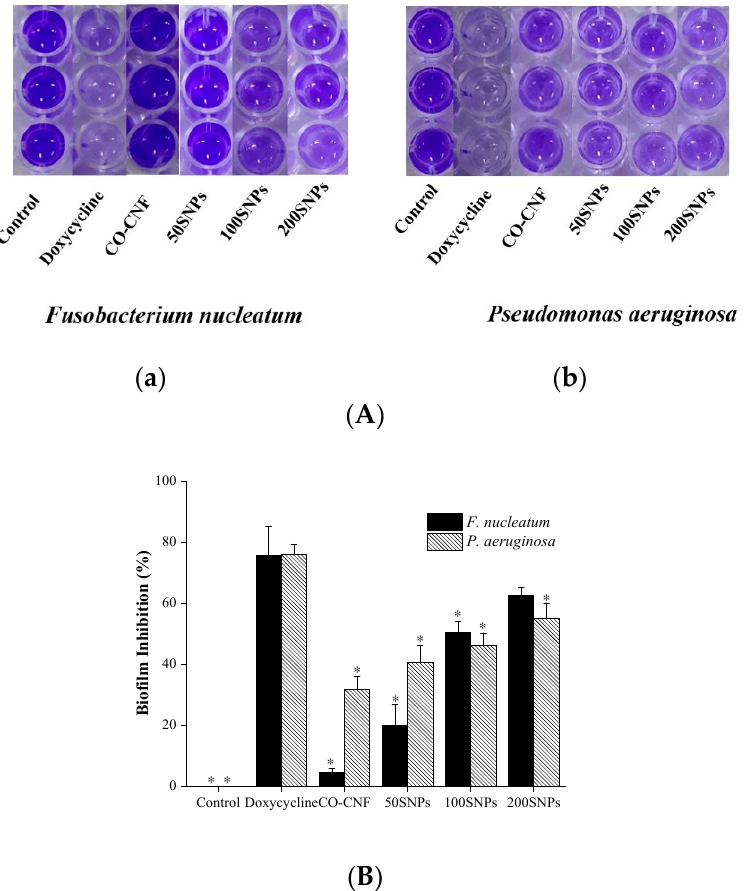
Figure 3. ( A )Visualization of biofilm formation by ( a ) Fusobacterium nucleatum and ( b ) Pseudomonas aeruginosa and ( B ) quantification of biofilm inhibition in Fusobacterium nucleatum and Pseudomonas aeruginosa . Data are expressed as mean ± S.D. ( n = 3). The asterisk (*) represent a significant difference ( p < 0.05) from positive control (doxycycline) analyzed by Tukey’s test. CO-CNF: κ -carrageenan oligosaccharides linked cellulose nanofibers; 50SNPs: 50 mg surfactin-loaded CO-CNF nanoparticles; 100SNPs: 100 mg surfactin-loaded CO-CNF nanoparticles; 200SNPs: 200 mg surfactin-loaded CO-CNF nanoparticles. CO-CNF